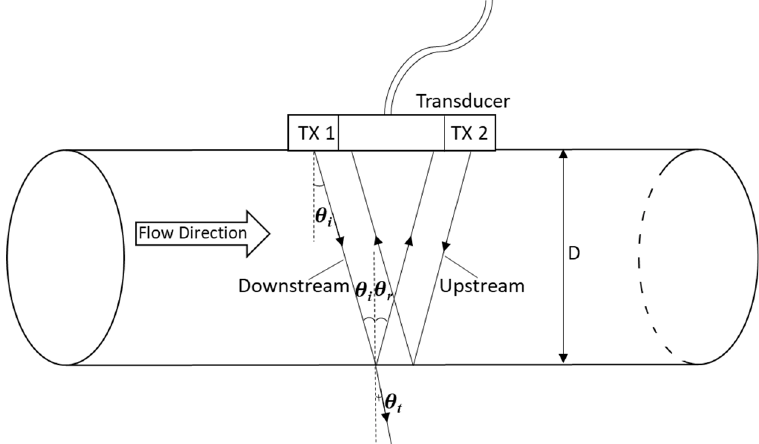
Figure 3. Illustration of pipe geometry and propagation and reflection of ultrasound waves.